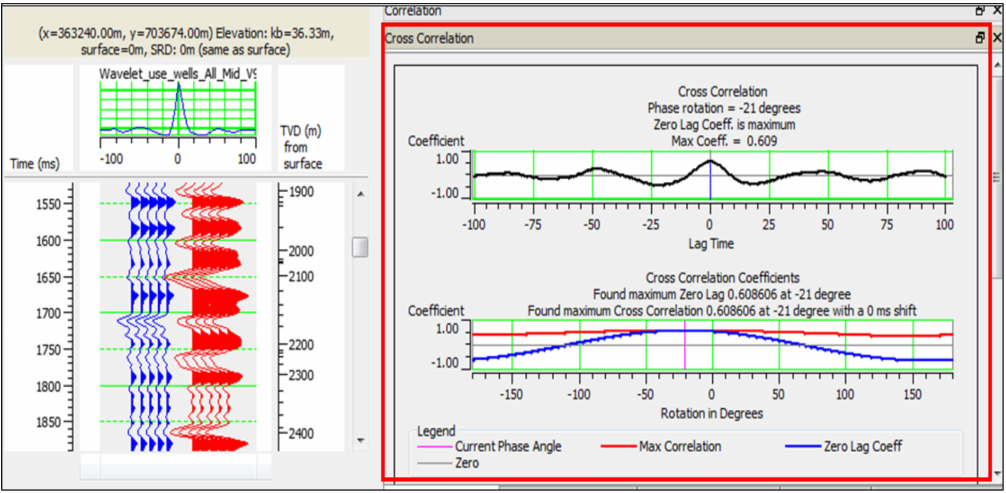
Figure 12. Synthetic seismogram ( blue ) generated from the well log and composite seismic traces ( red ) extracted from seismic data at the well location. A correlation window is displayed in the red